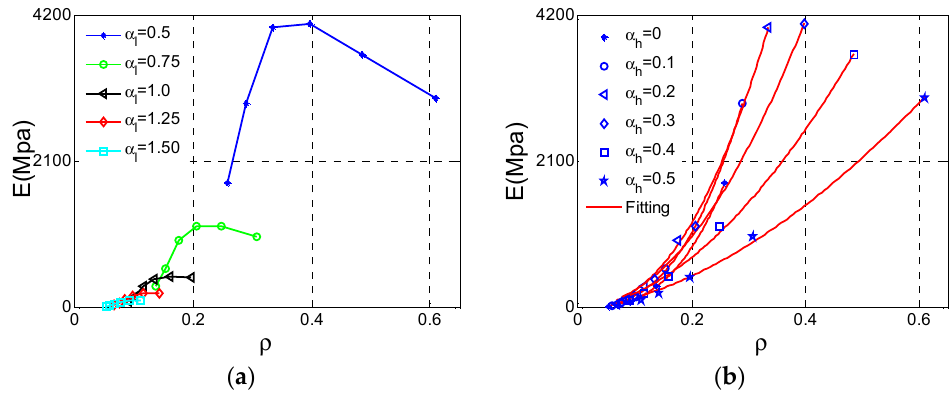
Figure 10. The changes of effective Young’s modulus E for Type B cell with respect to the relative density (cid:2025) : ( a ) data set; ( b ) fitting curves.